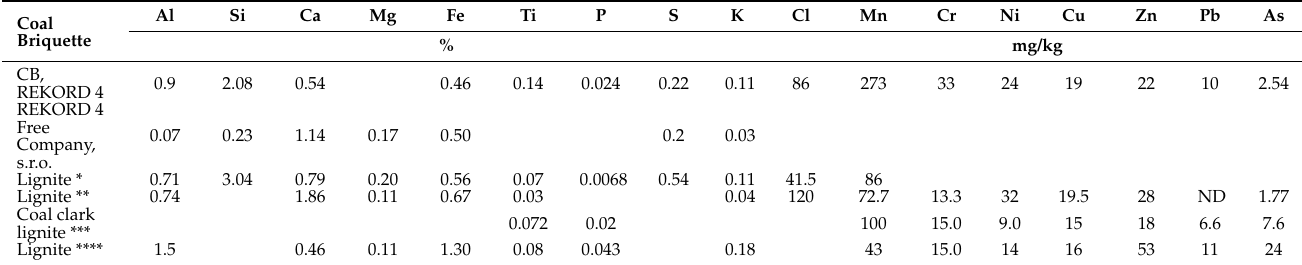
Table 6. Content of inorganic elements in CB and their comparison with literature values and coal Clarke values. Coal